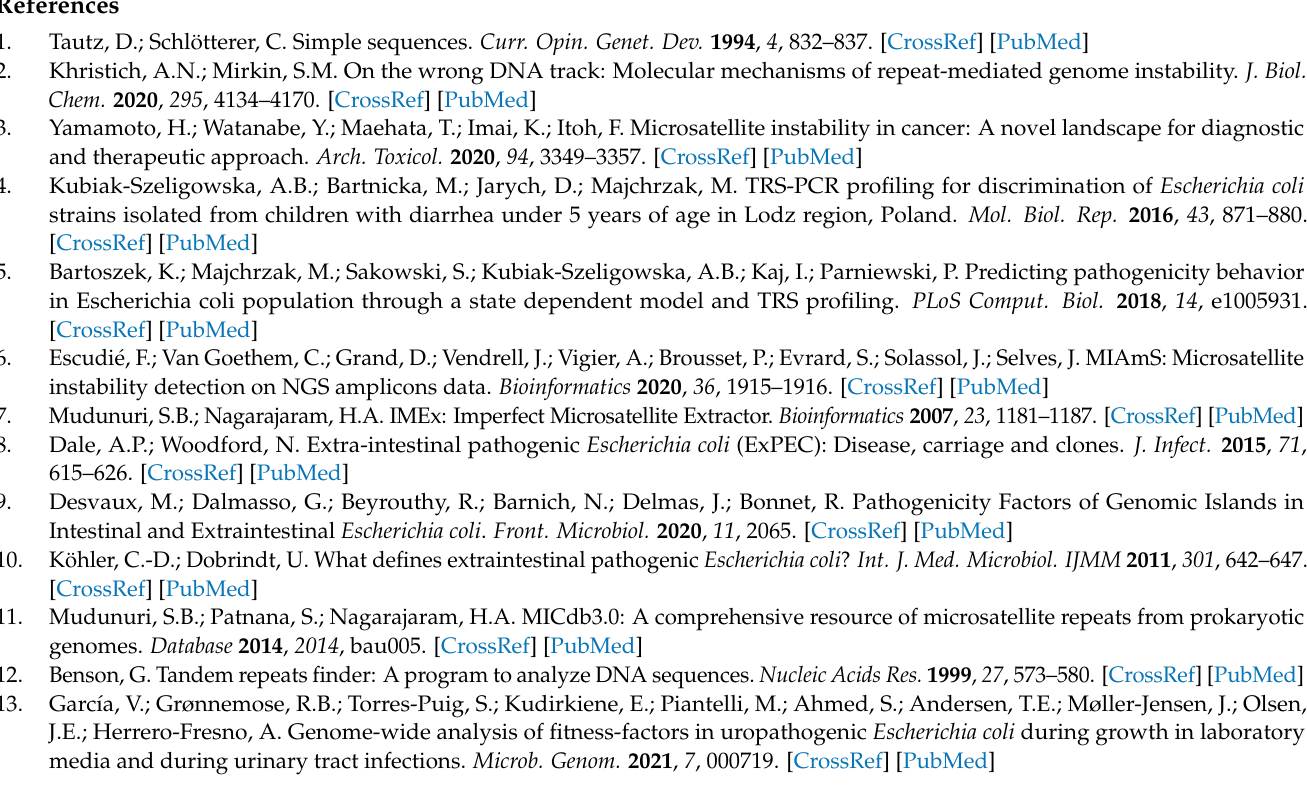
column was added showing the numbering of the sequences according to their position in the genome; Figure S4: Comparative analysis of the presence of DNA sequences between TRS class 1 motifs (CCG, CGC, GCC) and TRS class 8 motifs (CGT, GTC, TCG) in two genomes of Escherichia coli —UTI89 and O:157 H7 Sakai. Gray color marks non-perfect TRS motifs, and those sequences not found by the software (column [FRG GEN NO]). Red font marks nucleotides that disturb the canonical character of the TRS motif. Sequences that are unique in a given genome are marked in green. Only sequences ≥ 100 bp in length are shown. The percent of the identity of each pair of sequences is shown in the [Identity%] column; Figure S5: List of genomic sequences selected to check their specificity for genomes belonging to the IPEC pathotype and to the ExPEC